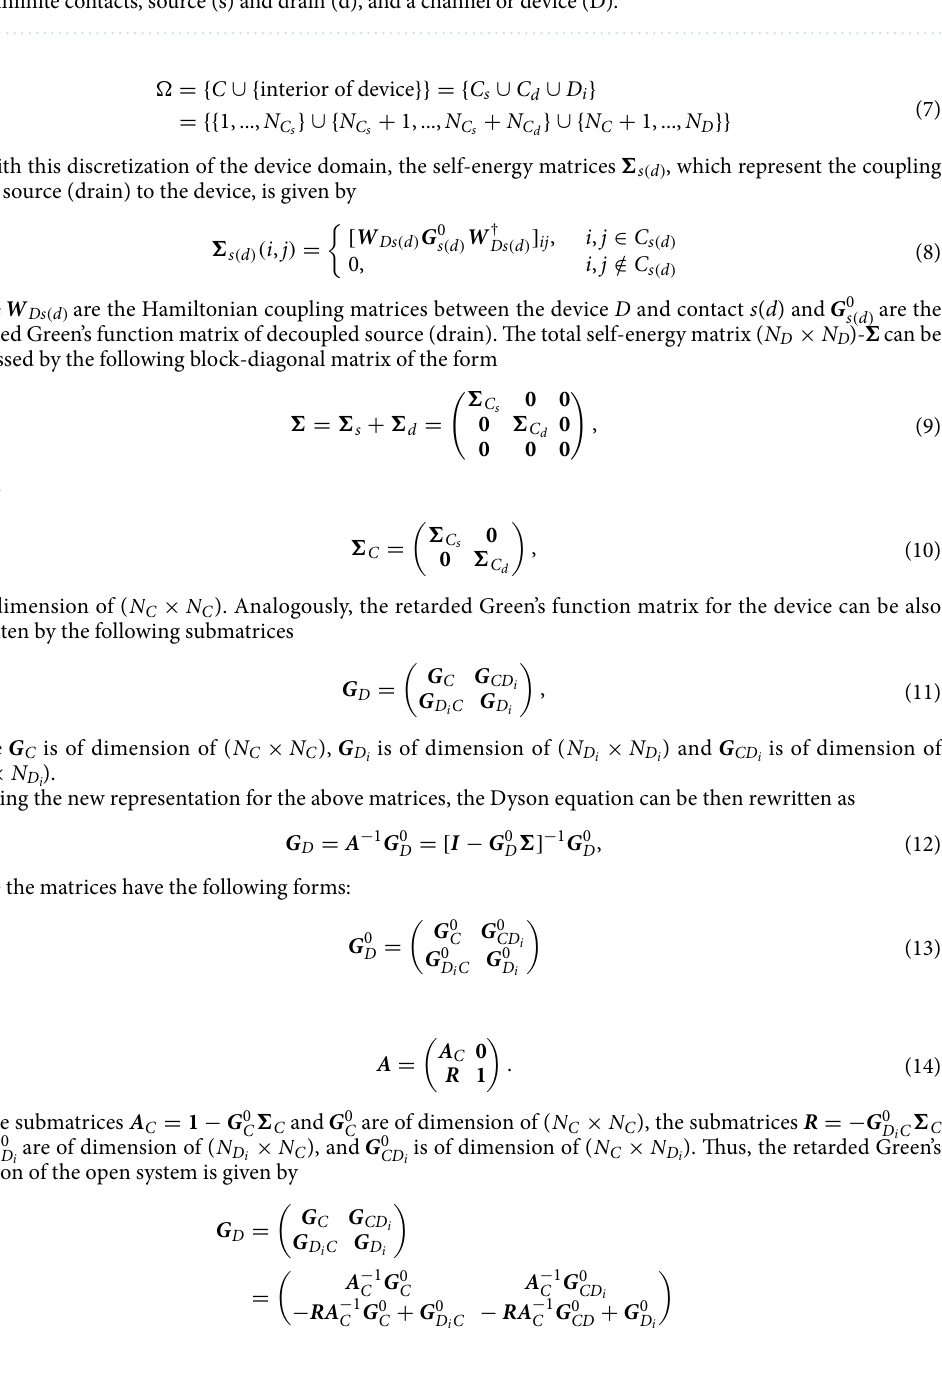
Figure 9. Schematic computational model for the CBR method. The two-contacts model is composed of two semi-infinite contacts, source (s) and drain (d), and a channel or device